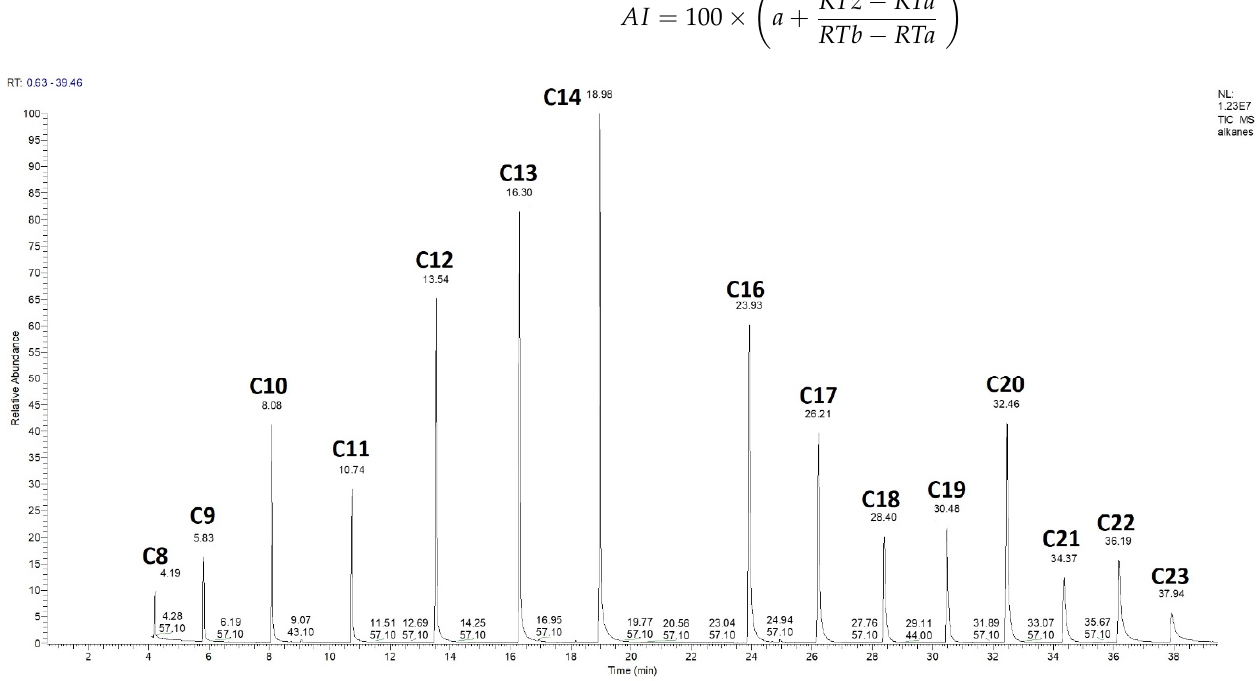
Figure 19. A series of n-alkanes used for calculation of arithmetic indices. This series goes from C8 to C23 but is missing C15.